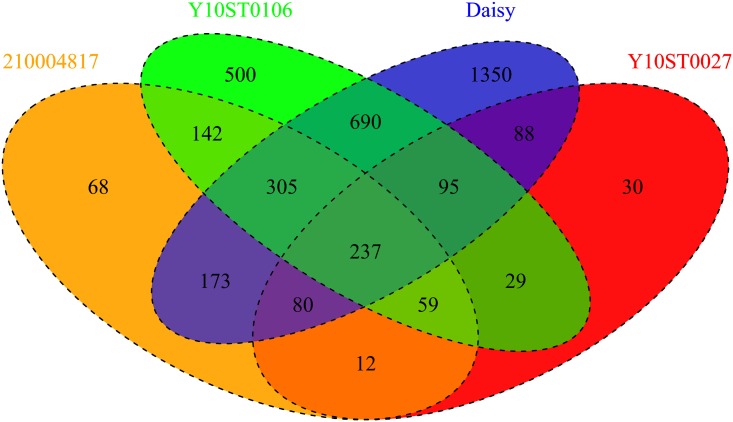
Venn diagram of number of validated class3 lncRNA with stranded blood libraries that are found between each animal. This figure represents the number of common and unique class 3 lncRNA validated with stranded RNA-Seq from blood that are found in each animal. The green circle represents the validated lncRNA found in the cow 210004817. The orange circle represents the validated lncRNA found in the cow Y10ST0106. The blue circle represents the class 3 lncRNA found in the cow daisy. The red circle represents the validated lncRNA found in the cow Y10ST0027. In the very middle we see that 237 validated class 3 lncRNA are found in all 4 animals.